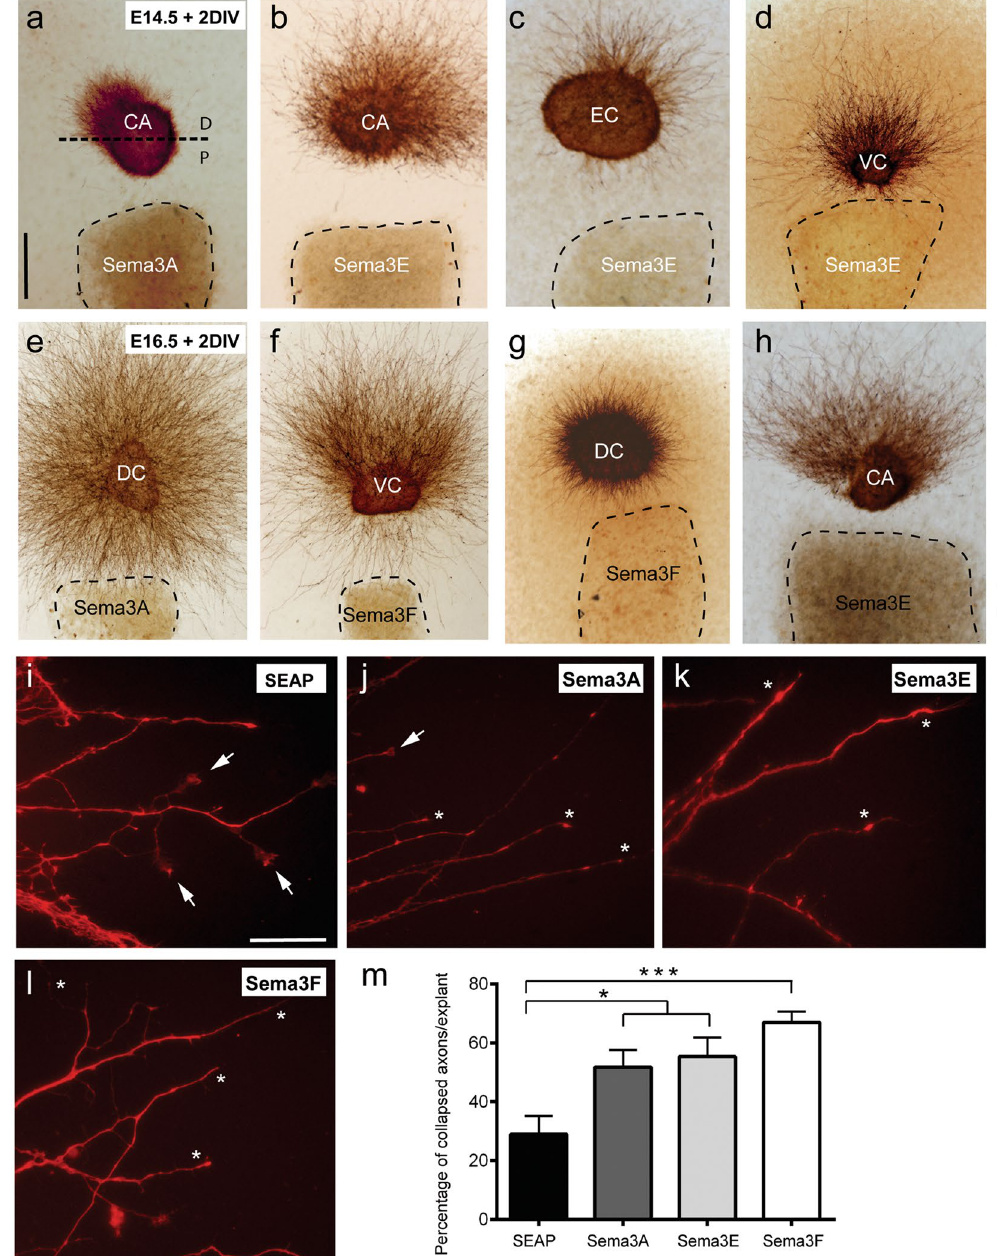
Figure 2. Low-power photomicrographs showing examples of the chemorepulsion of hippocampal ( a,b , h ), entorhinal ( c ), ventrolateral ( d and f ) and dorsal ( e and g ) axons by Sema3A, Sema3F and Sema3E. Explants were obtained at E14.5 ( a–d ) or E16.5 ( e–h ), cultured for 2 days in vitro (DIV) and processed for β III-tubulin (clone TUJ-1) immunostaining. (a) Dotted line defines the boundary between the proximal (P) and the distal (D) quadrant of the explants. Note the strong chemorepulsion of hippocampal axons by Sema3A at E14.5. In addition, Sema3E-mediated chemorepulsion can be seen on hippocampal, entorhinal and ventrolateral cortex at E14.5 ( b–d ). Examples of Sema3F-mediated chemorepulsion on ventrolateral axons and Sema3E- effects on hippocampal axons can be seen in f and h respectively. This contrasts with what is observed for dorsal neocortical axons ( g ). ( i – m ) Representative phalloidin-TRITC stained neuronal processes of cultured entorhinal explants from E16.5, illustrating semaphorin-mediated growth cone collapse. (i) Normal growth cones, with lamellipodia and filopodia (arrows) from entorhinal explants cultured with SEAP medium. ( j – l ) Examples of collapsed growth cones (asterisks) after incubation with Sema3A ( j ), Sema3E ( k ) and Sema3F ( l ). ( m ) Histogram illustrating percentages of collapsed growth cones per explant after the incubation of entorhinal explants with secreted semaphorins. Results represent the mean ± S.E.M. of three separate experiments. Asterisks indicate statistical differences between groups and controls. *** P ≤ 0.001; ANOVA Bonferroni post hoc test. Abbreviations: CA = CA1-3 hippocampal regions; EC = entorhinal cortex; DC = dorsal neocortex; VC = ventrolateral neocortex. Scale bars: a = 150 μ m pertains to ( b – h ); i = 20 μ m pertains to ( j – l